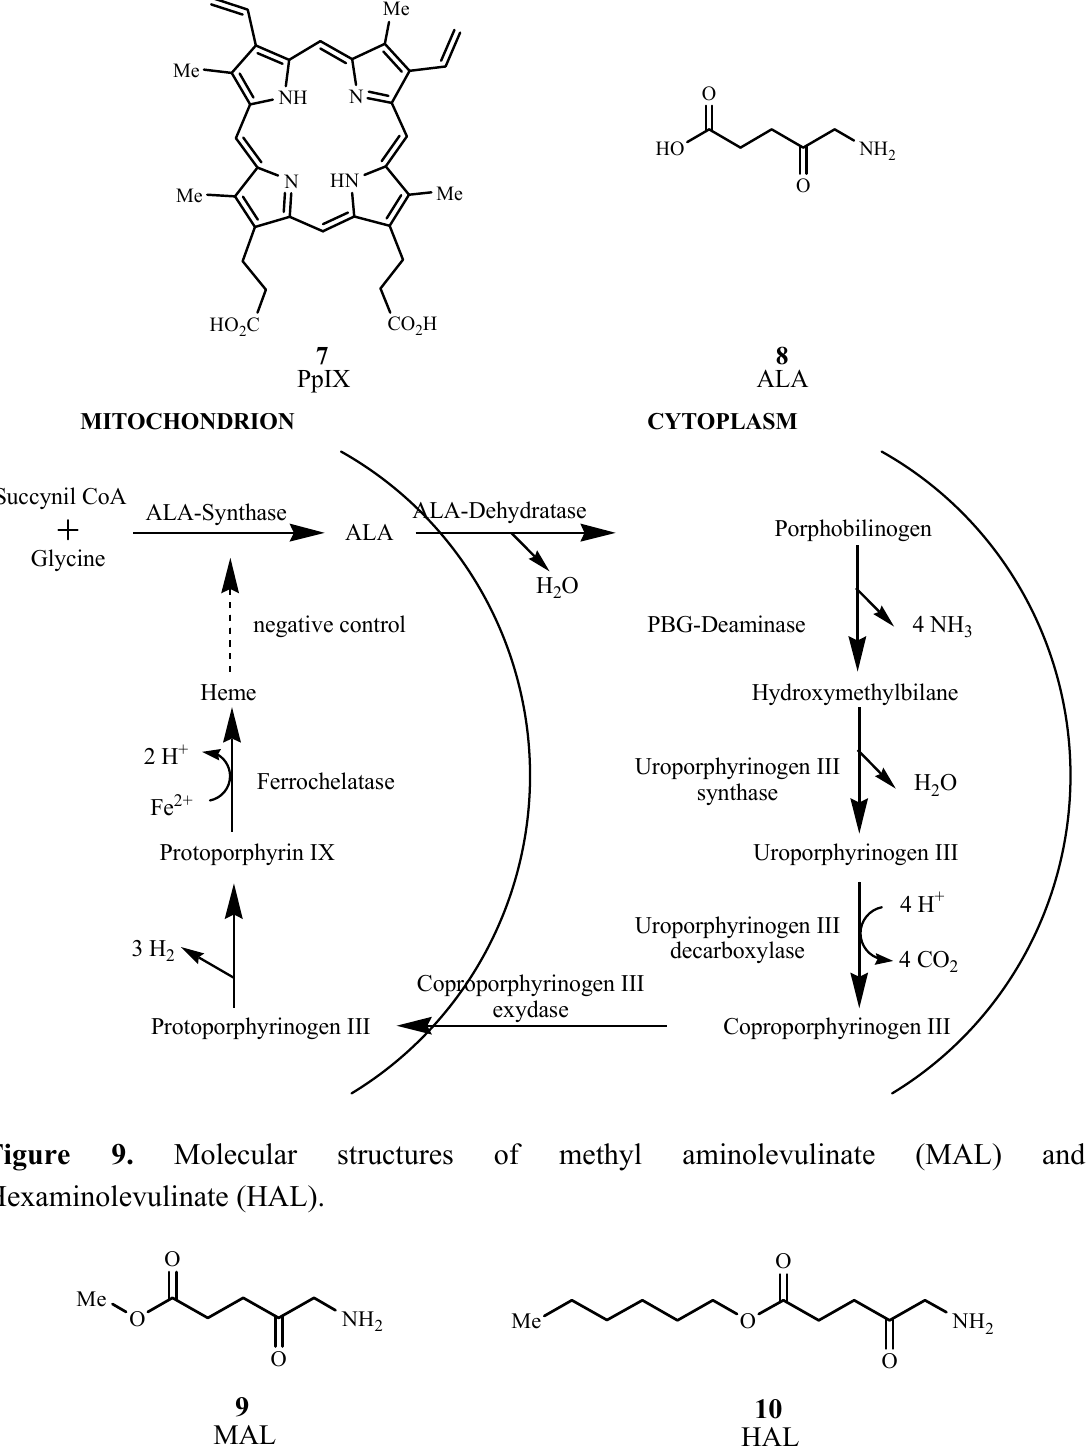
Figure 9. Molecular structures of methyl aminolevulinate (MAL) and Hexaminolevulinate